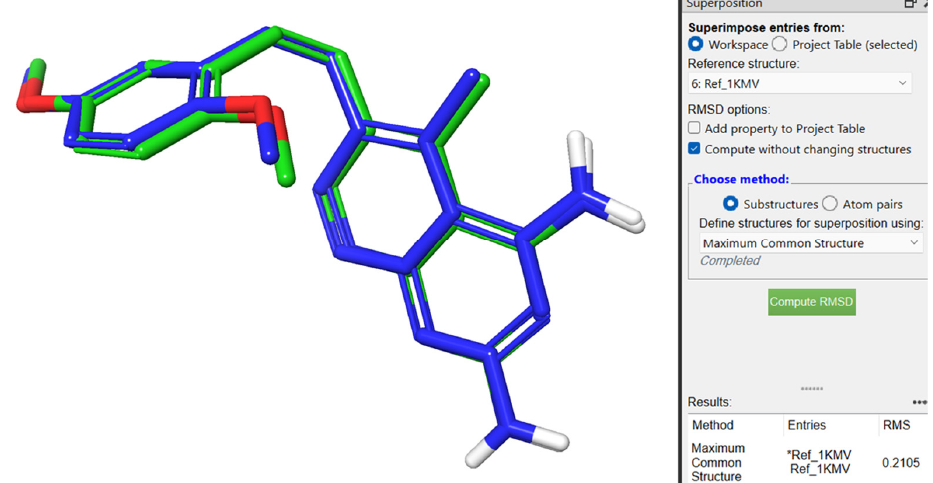
Figure 6. Superimposition of 3D structures with element color atoms of co-crystallized (carbon atoms customized blue) over redocked (carbon atoms customized green) reference inhibitor SRI-9662 (named Ref_1KMV in the figure).